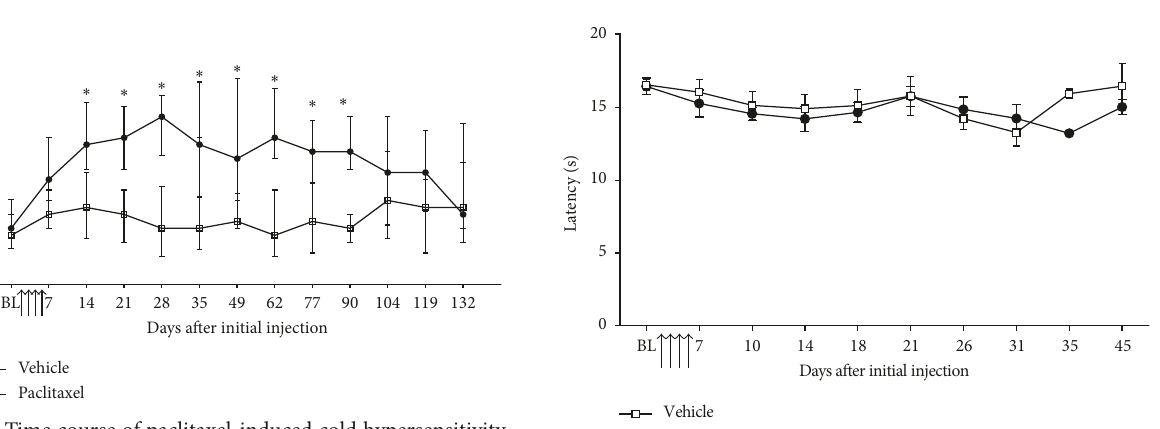
baseline before paclitaxel/vehicle administration. Res (cid:31) p ∗